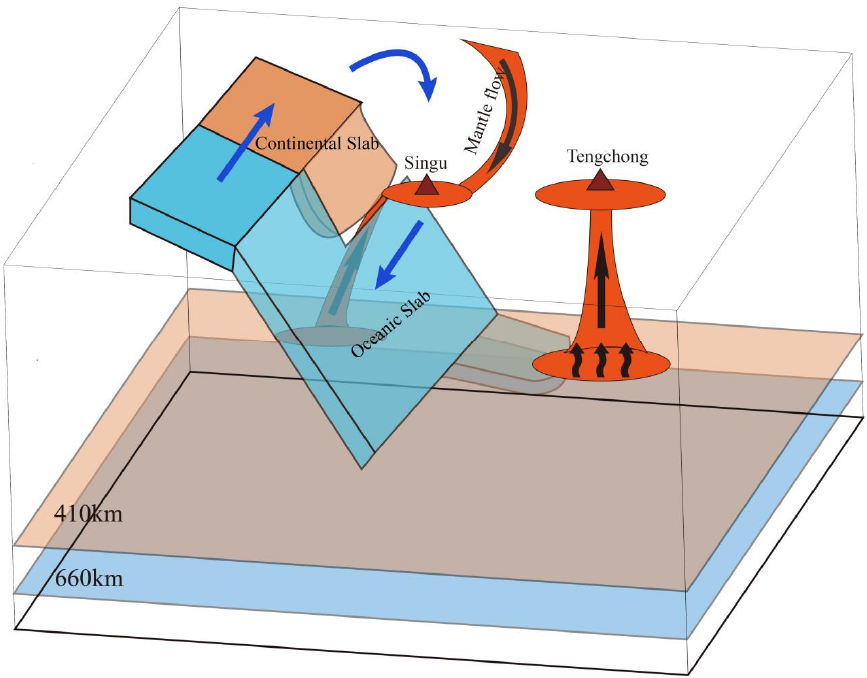
Figure 9. The detachment of the Indian Ocean lithosphere and the continental lithosphere as a trigger for the Singu volcano. The ground displacement is marked with three blue arrows (Gahalaut et al.; Maurin et al.) [59,60].